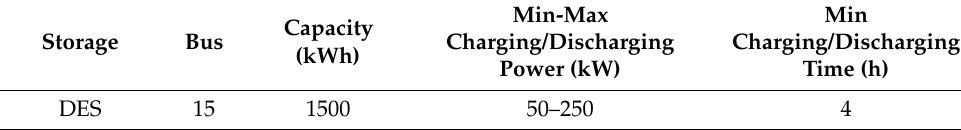
Table 4. Characteristics of the energy storage.